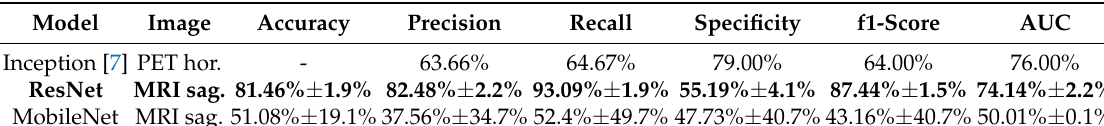
Table 1. Best results for